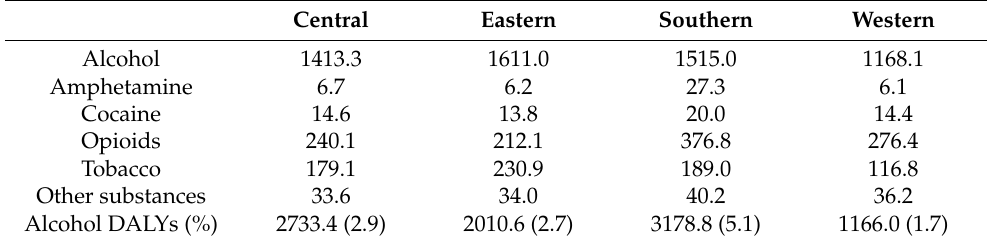
Table 1. Age-standardized estimates of substance use prevalence in sub-Saharan Africa per 100,000 people and DALYs attributable to alcohol and substances, Global Burden of Disease Study, 2016 [20,30,47,98]. Central Eastern Southern Western